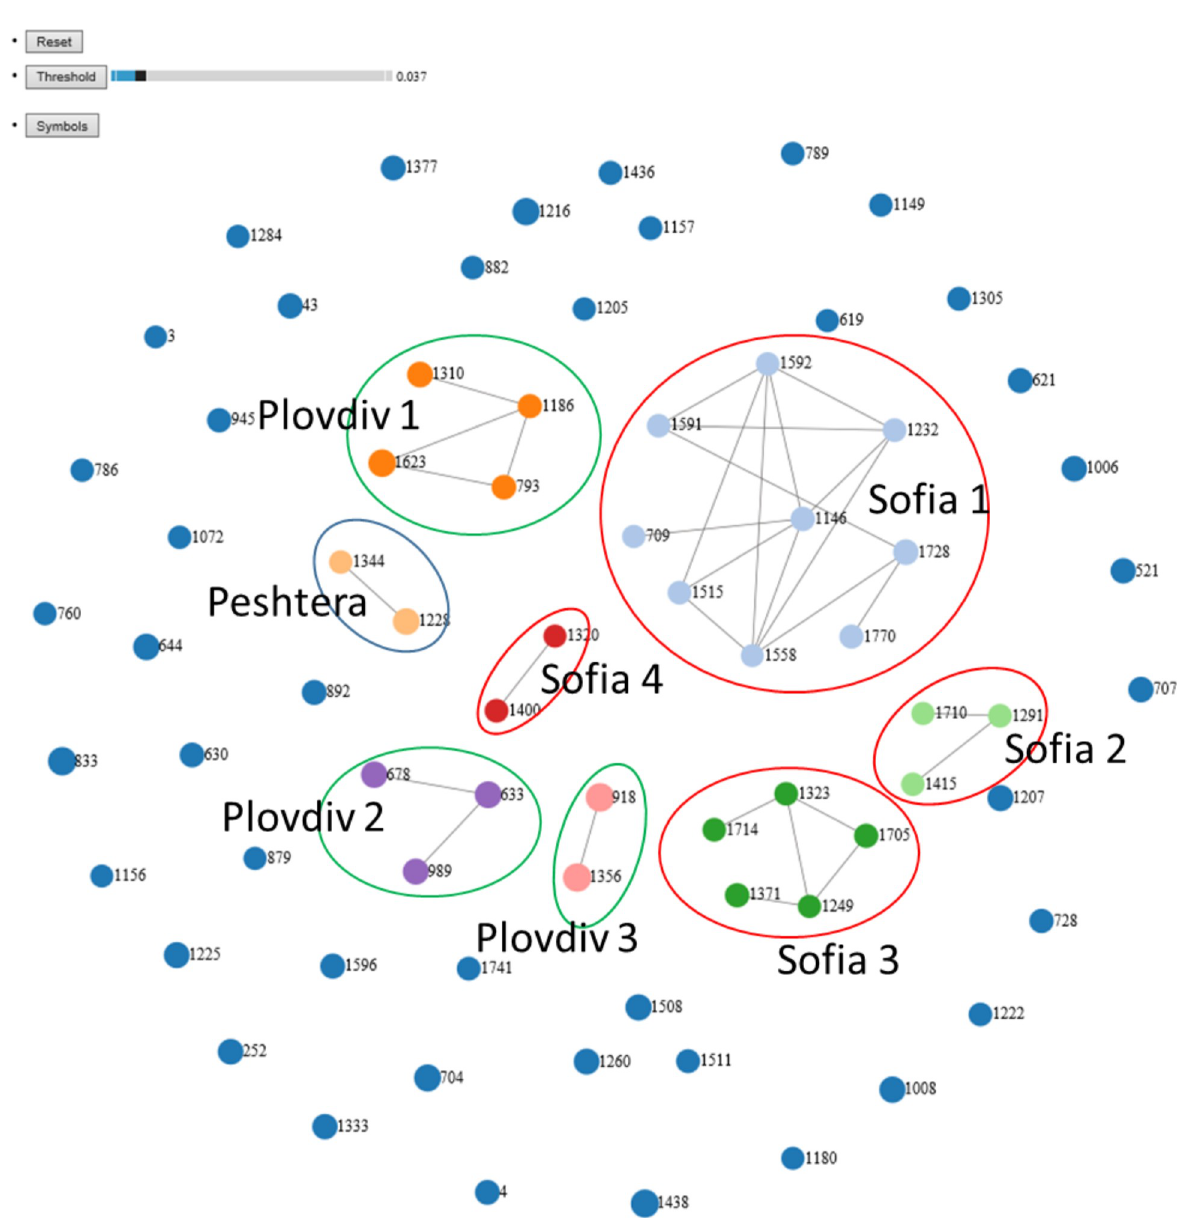
Fig 3. Transmission networks. Nodes represent HCV infected persons. Cases sharing an HCV strain are shown as 2 nodes linked by line (transmission link). Dark blue unlinked nodes–unrelated cases; Clusters are identified by the node color and encircled—Sofia 1(n = 9, genotype 1a) —light blue; Sofia 2 (n = 5, genotype 1a)—dark green; Plovdiv 1 (n = 4, genotype 1a)—dark orange; Sofia 3, 1a (n = 3, genotype 1a)—light green; Plovdiv 2, (n = 3, genotype 3a)—purple; Plovdiv 3, (n = 2, genotype 3a)—pink; Sofia 4, (n = 2, genotype 1b)—red; Peshtera (n = 2, genotype 1b)— light